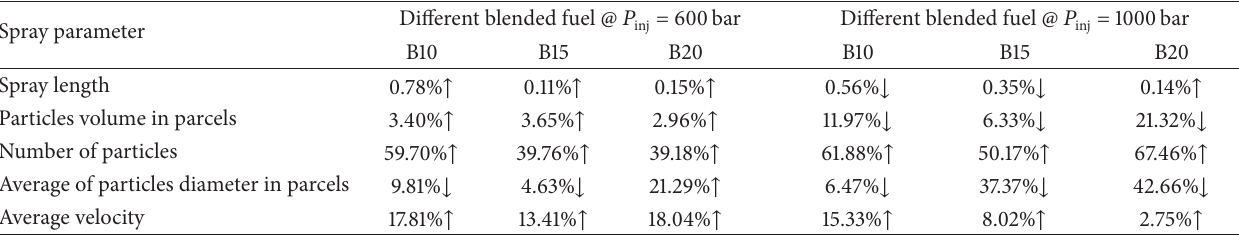
Table 6: Summary of the different fuel blends effects on the spray characteristics compared to pure HFO fuel. Spray parameter